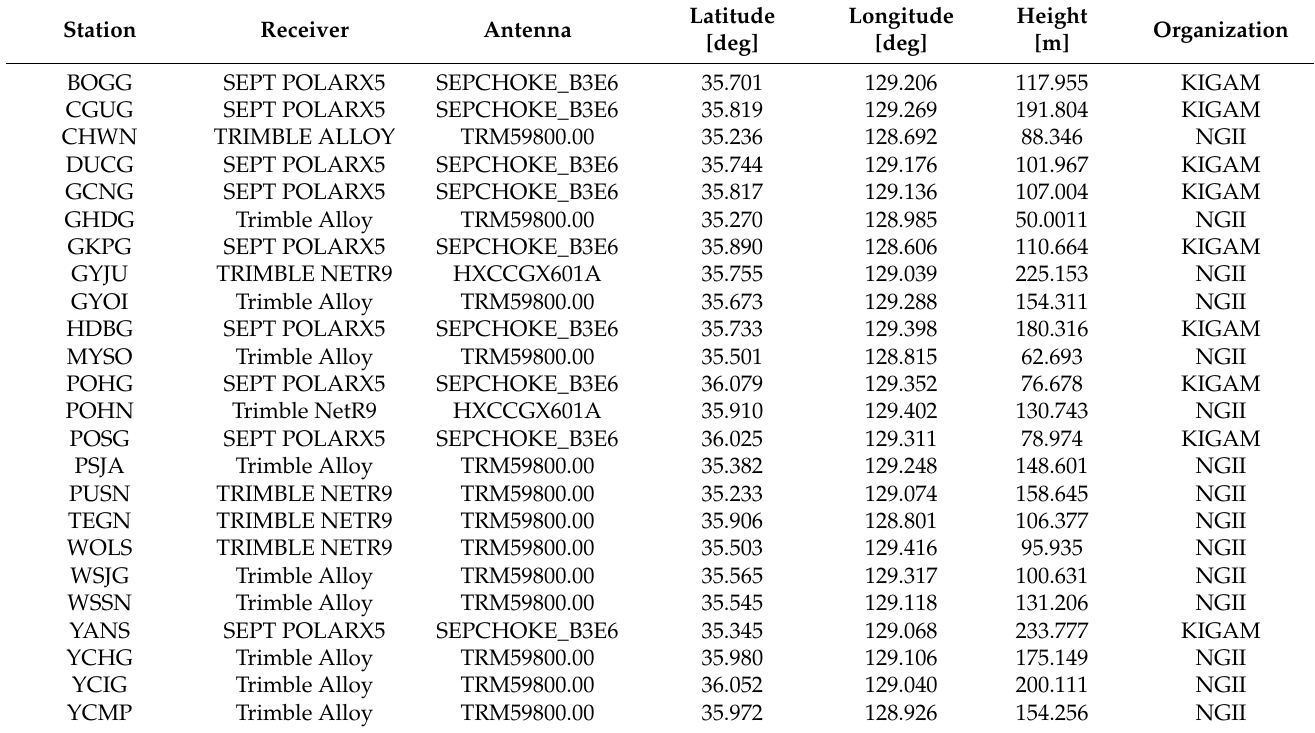
Table 1. A list of domestic GNSS